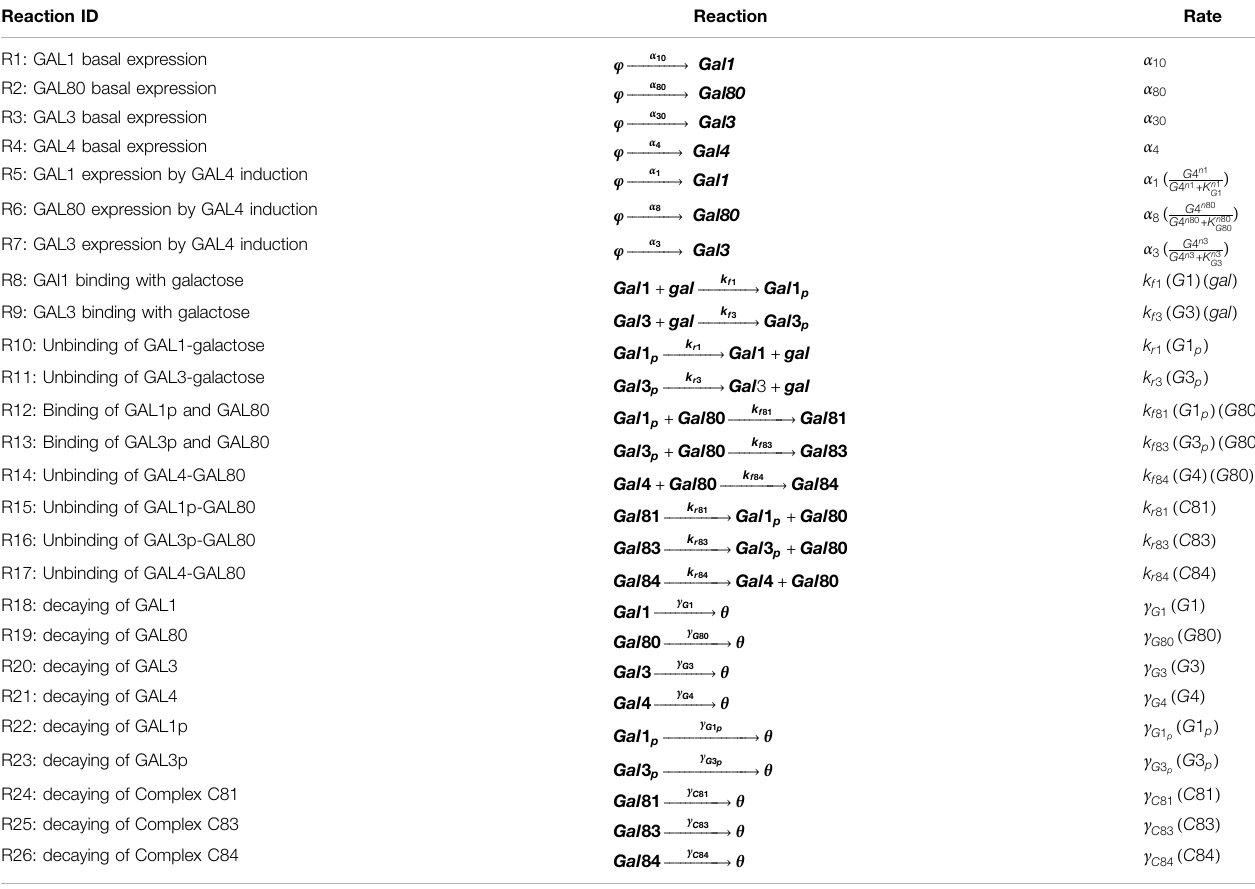
TABLE 2 | Reaction events and reaction rate used to simulate stochastic model. Reaction ID Reaction